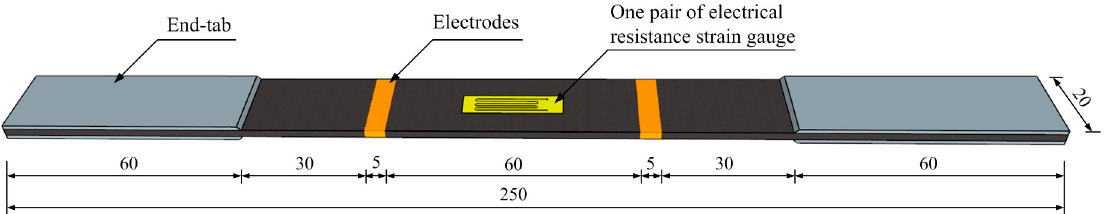
Figure 2. Schematic of CNF/GFRP laminates (units in mm).